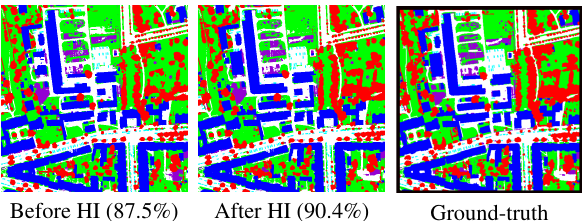
Figure 13. Full predictions and their accuracy before/after human interaction (HI) on an image from